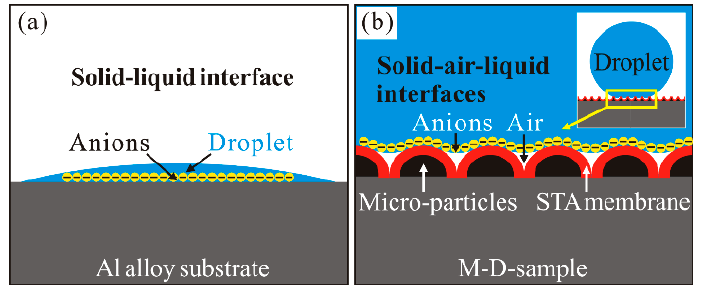
Figure 7. Interfacial relationships of ( a ) Al alloy substrate and ( b ) modified deposited sample.